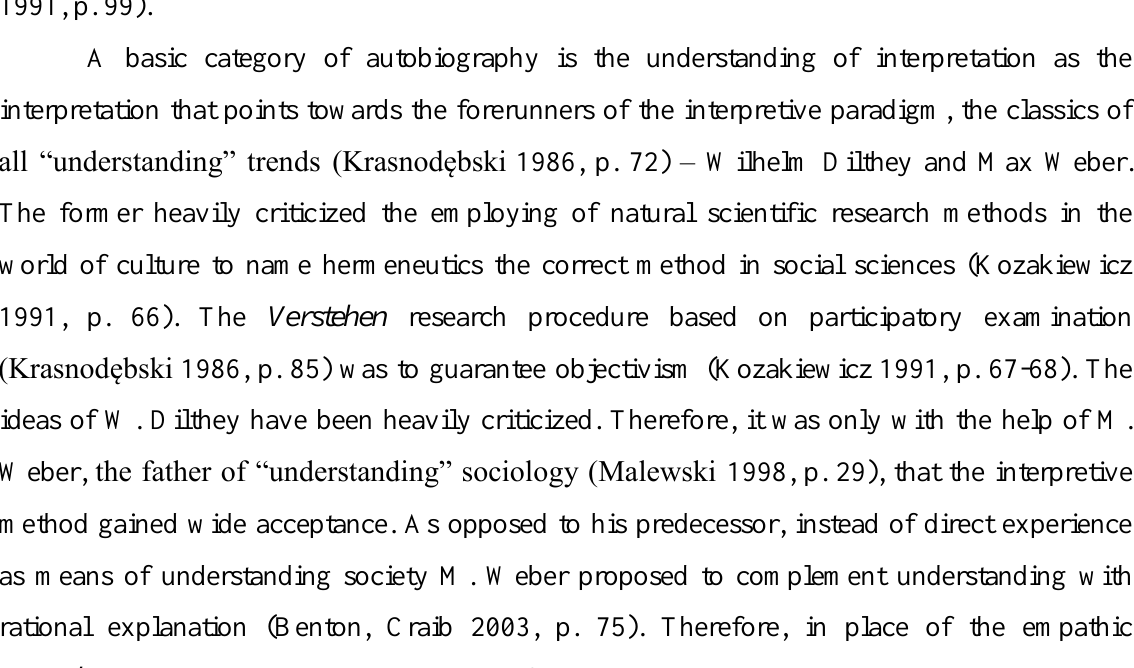
Fig. 3. Narrative-auto/biographical research; source: compiled by the